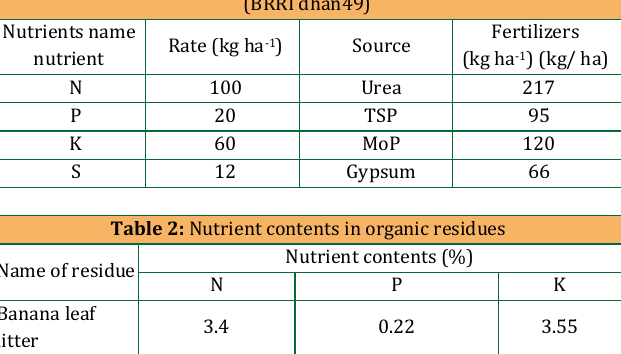
Table 1. Chemical compositions of the banana leaf litter used is presented in Table 2. Table 1: Sources and rate of nutrients and chemical fertilizers for rice (BRRI dhan49)